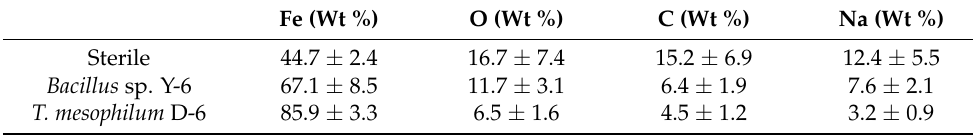
Table 1. Content of Fe, O, C and Na in corrosion products obtained with EDS test.